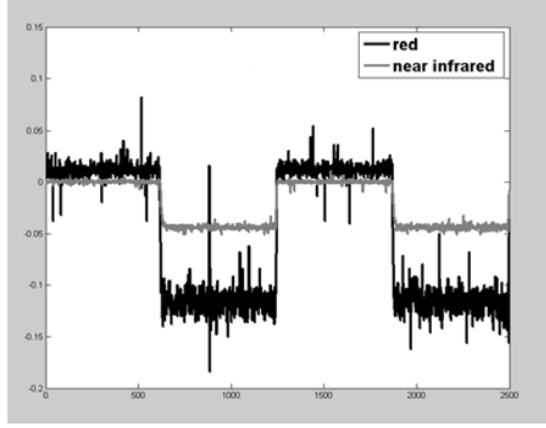
Figure 2. Backscatter signals of two-wavelength